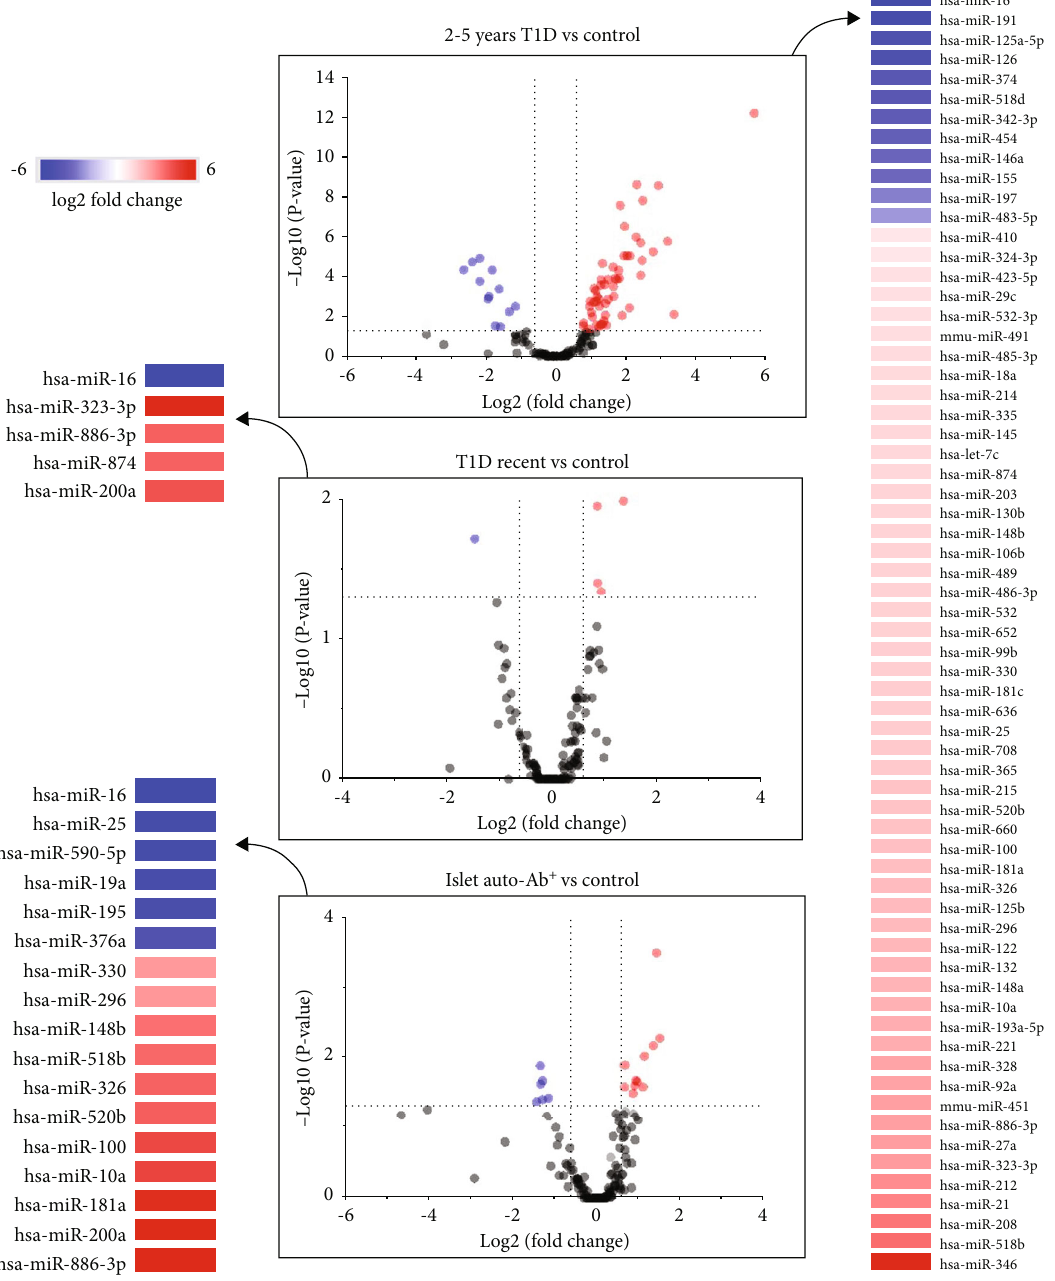
Figure 2: Volcano plots with changes in miRNAs levels between the AbP group (individuals with islet autoantibodies without diabetes; n = 25 ), recent T1D group (newly diagnosed T1D patients with duration ≤ 6 months; n = 30 ), and T1D 2-5y group (patients with T1D with 2 to 5 years of duration; n = 26 ) in comparison with health controls ( n = 29 ).The log fold change is shown on the X -axis and log 2 of the p value on the Y